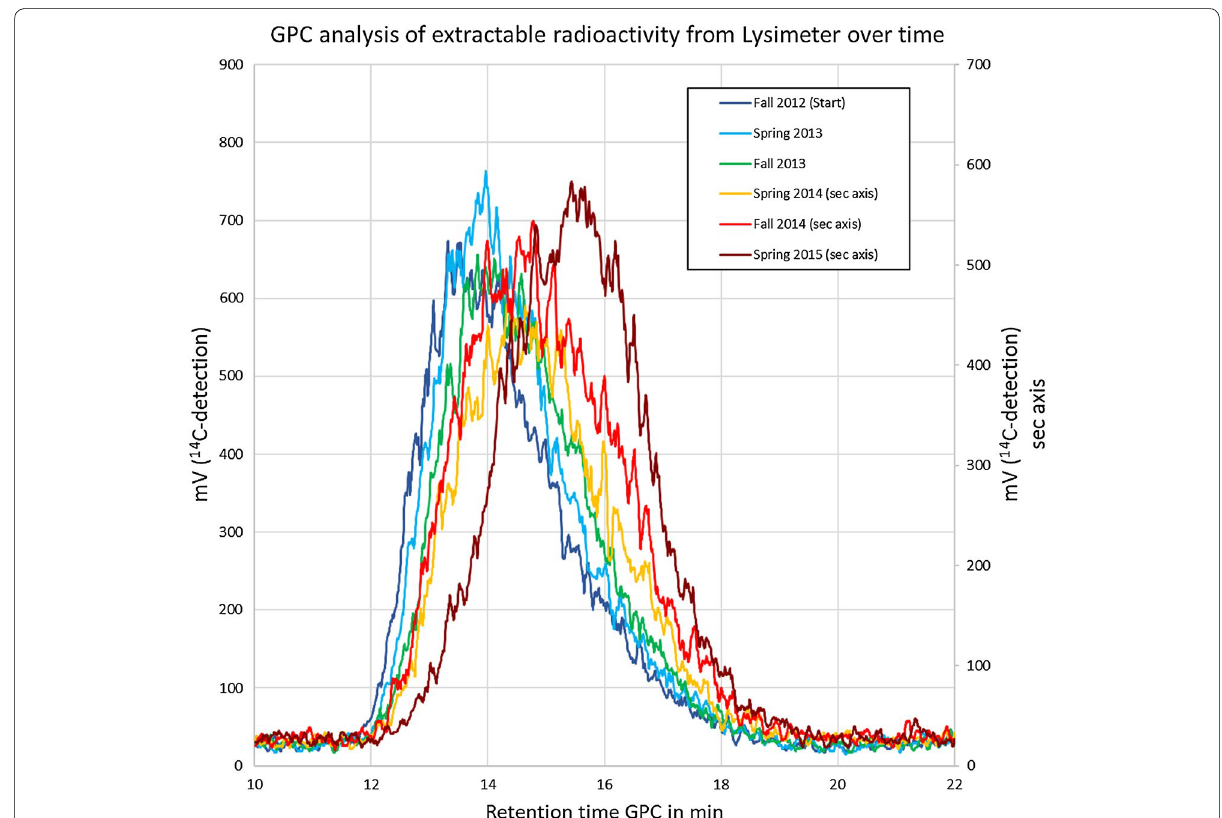
Fig. 7 Overlay of GPC-signals from lysimeter soil extracts obtained by